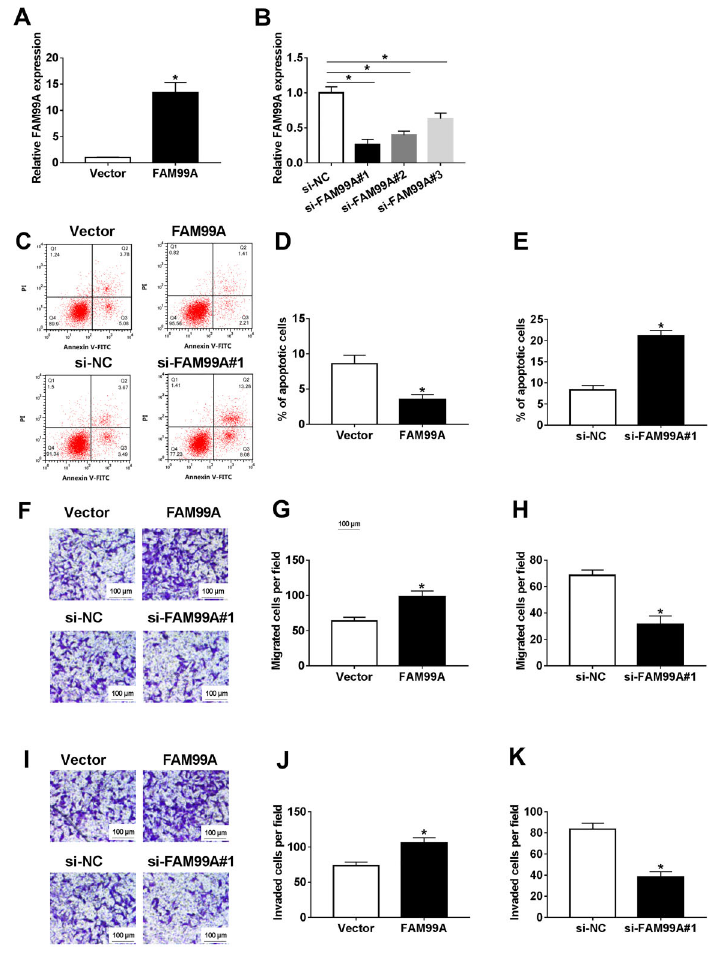
Figure 2. A , The level of FAM99A in HTR8/SVneo cells transfected with FAM99A mimics or negative control was detected by qRT- PCR. B , The level of FAM99A in HTR8/SVneo cells transfected with si-FAM99A (si-FAM99A#1, si-FAM99A#2, and si-FAM99A#3) or negative control si-NC was detected by qRT-PCR. C – K , The HTR8/SVneo cells were transfected with FAM99A mimics, si-FAM99A, or negative controls (Vector, si-NC). C – E , The apoptotic rate was evaluated by fl ow cytometry. F – K , The migrated and invaded cells per fi eld were calculated via Transwell assay (scale bar 100 m m). Data are reported as means ± SD. *P o 0.05 (Student ’ s t -test or ANOVA).